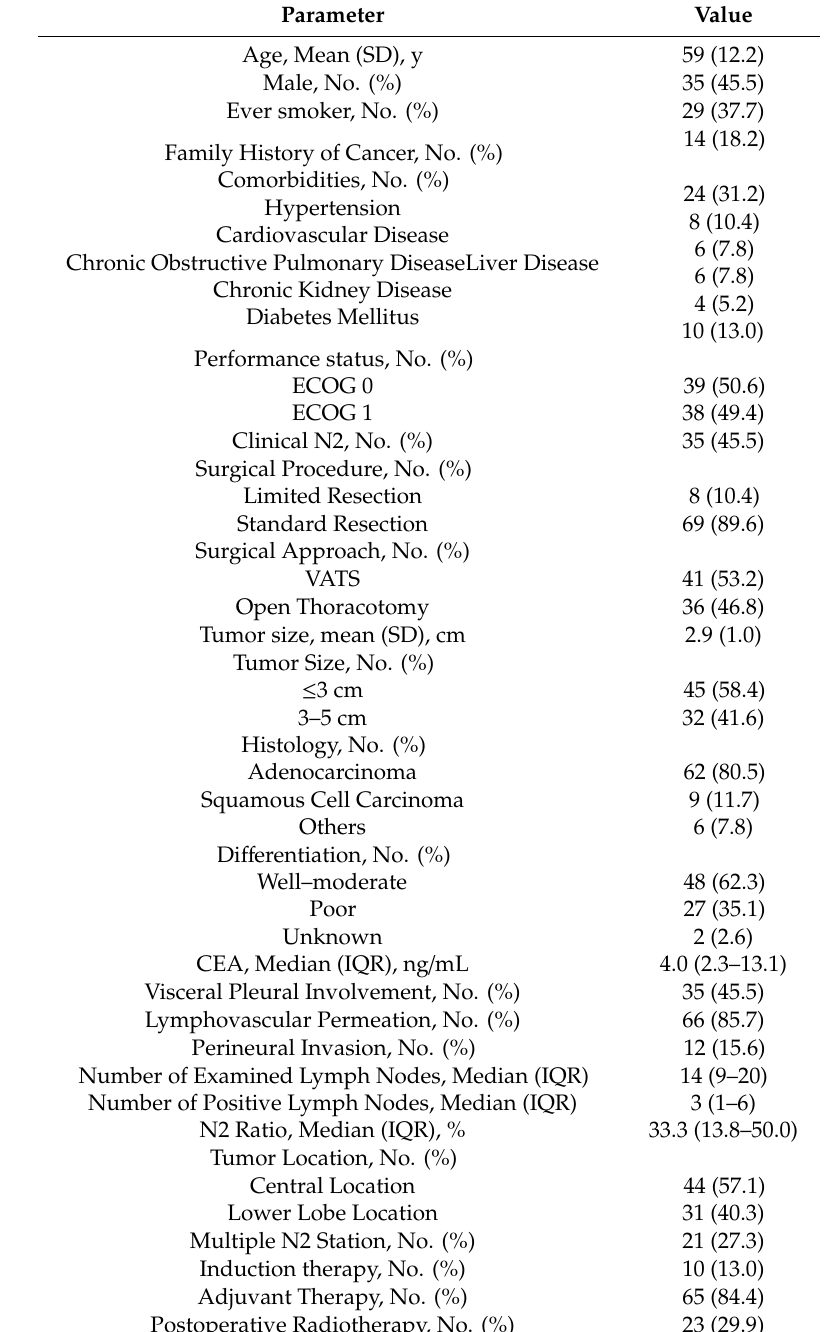
Table 1. Demographic and clinicopathologic characteristics of 77 patients with resected stage IIIA-N2 non-small-cell lung